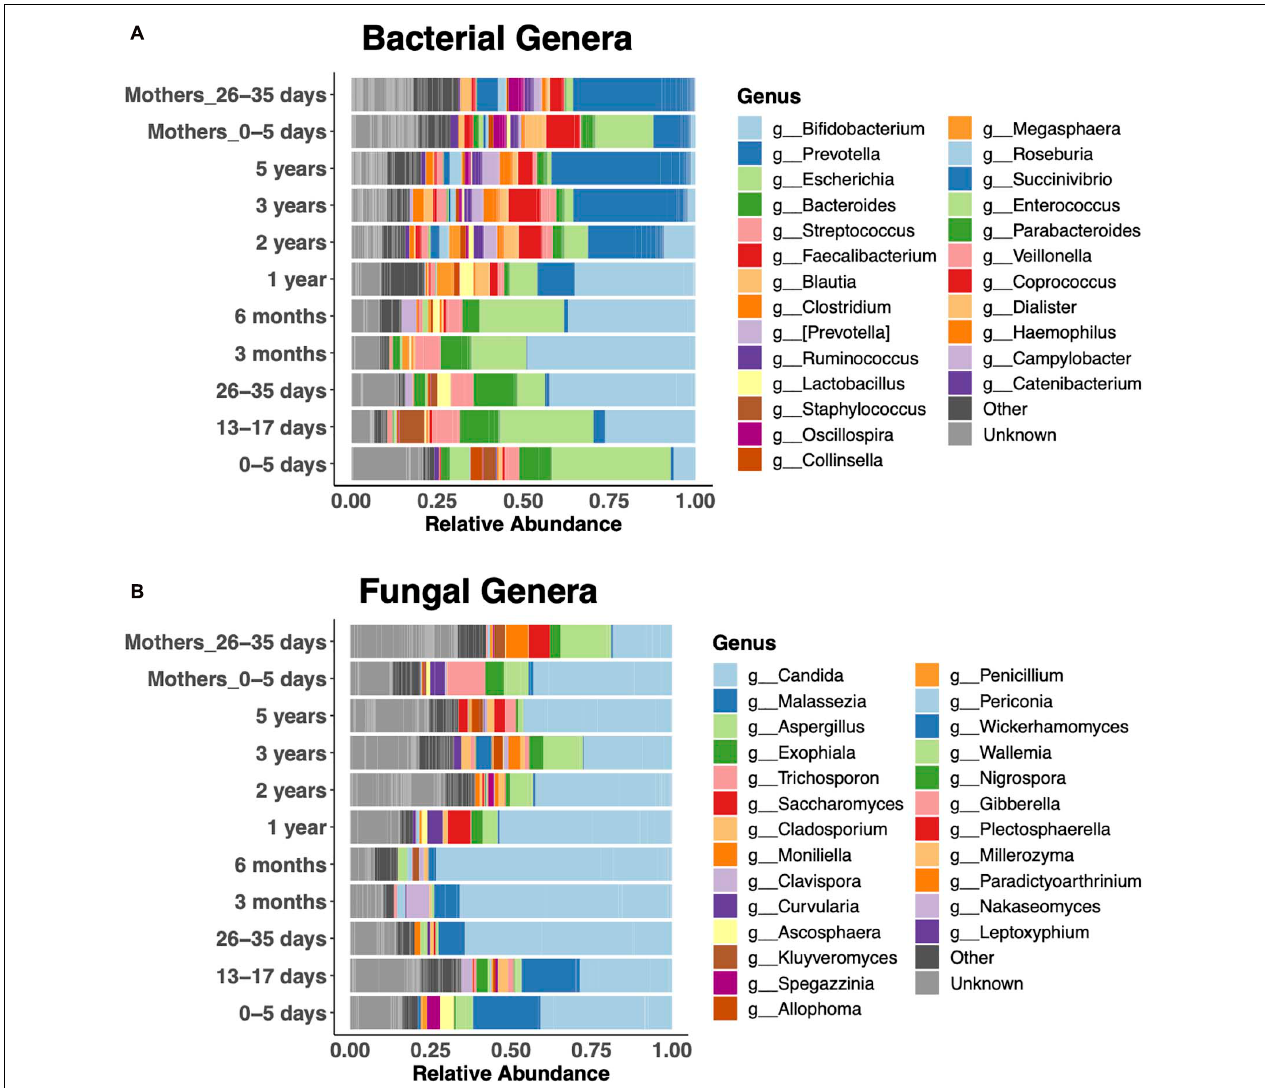
FIGURE 3 | Relative abundance of the 25 most abundant genera. Bacterial (A) and fungal (B) community composition across the age